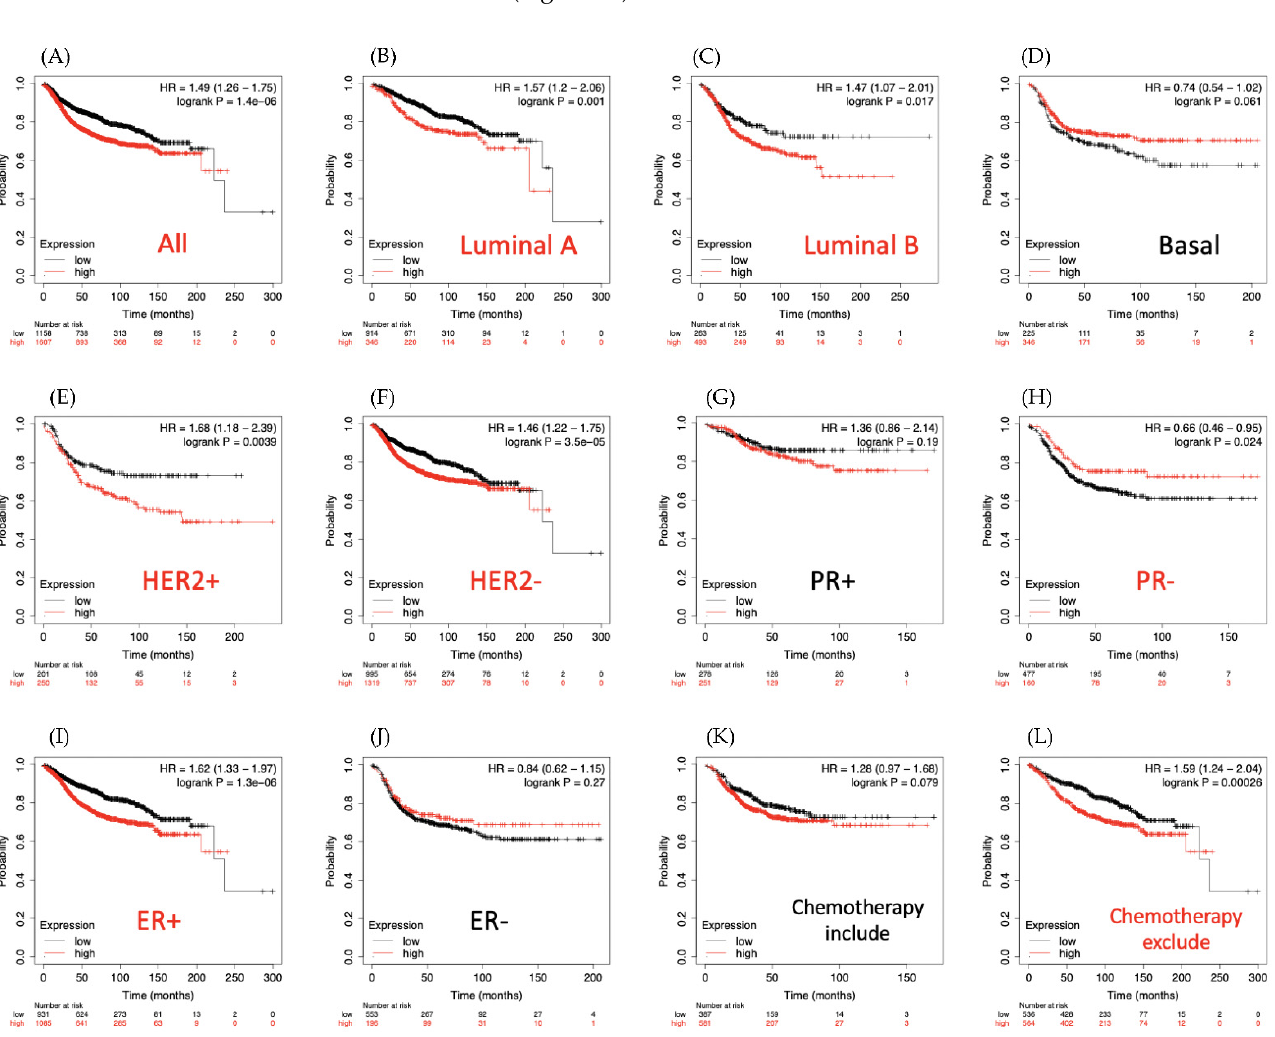
Figure 9. Relationship of distant metastasis-free survival (DMFS) and LAGE3 expression levels with clinical breast cancer patients ( n = 2898). DMFS prognoses of clinical BRCA patients are shown in Kaplan-Meier graphs, based on LAGE3 mRNA expression levels. ( A ) Overall survival, ( B ) Luminal A subtype, ( C ) Luminal B subtype, ( D ) Basal subtype, ( E ) HER2 + subtype, ( F ) HER2 − subtype, ( G ) PR + subtype, ( H ) PR − subtype, ( I ) ER + subtype, ( J ) ER − subtype, ( K ) survival analysis for chemotherapy-treated patients and ( L ) chemotherapy untreated patients. An auto-cutoff applied in this analysis helped to create two groups of patients based on the best cutoff value of LAGE3 mRNA, as demonstrated in red (high) and black (low). LAGE3 with high expression levels was considerably correlated with poor survival outcomes; the red label of survival curves stands for significant p-value, whereas black label indicates a non-significant outcome.